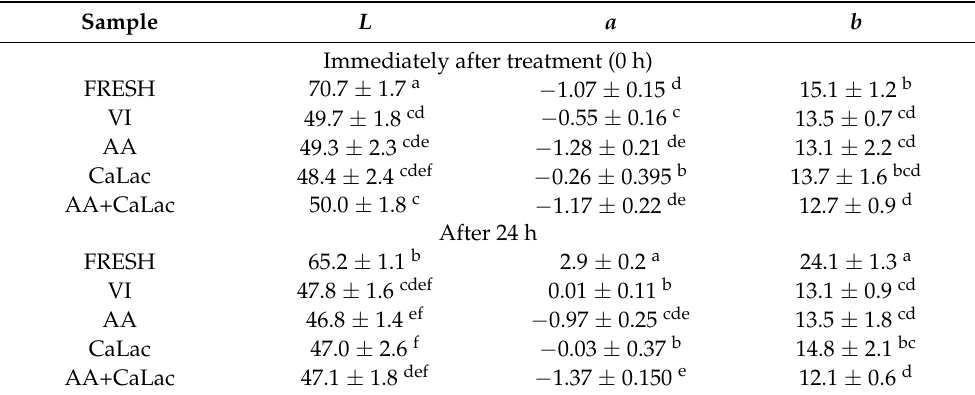
Table 4. Color parameters of fresh and vacuum-impregnated samples immediately after the vacuum impregnation (VI) treatment and 24 h